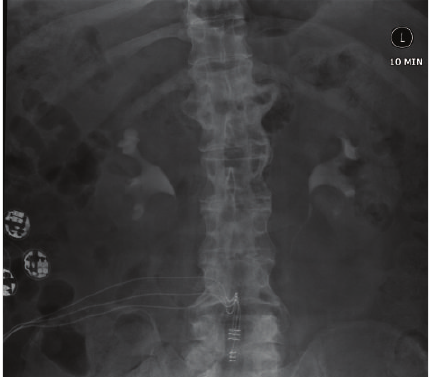
Figure 2: Case 2: ten-minute film of intravenous urography, per- formed in February 2008, showing some blunting of the right upper pole calyx with some reduction in cortical thickness at the right upper pole compatible with chronic pyelonephritis. Otherwise, both pelvicalyceal systems and ureters appear normal. The intradural electrodes of the sacral anterior nerve roots and the receiver block implanted in right flank can be seen.